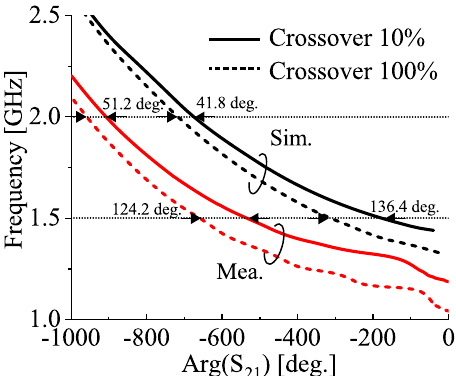
Fig. 15. Phase of S 21 characteristics of 5-cell transmission